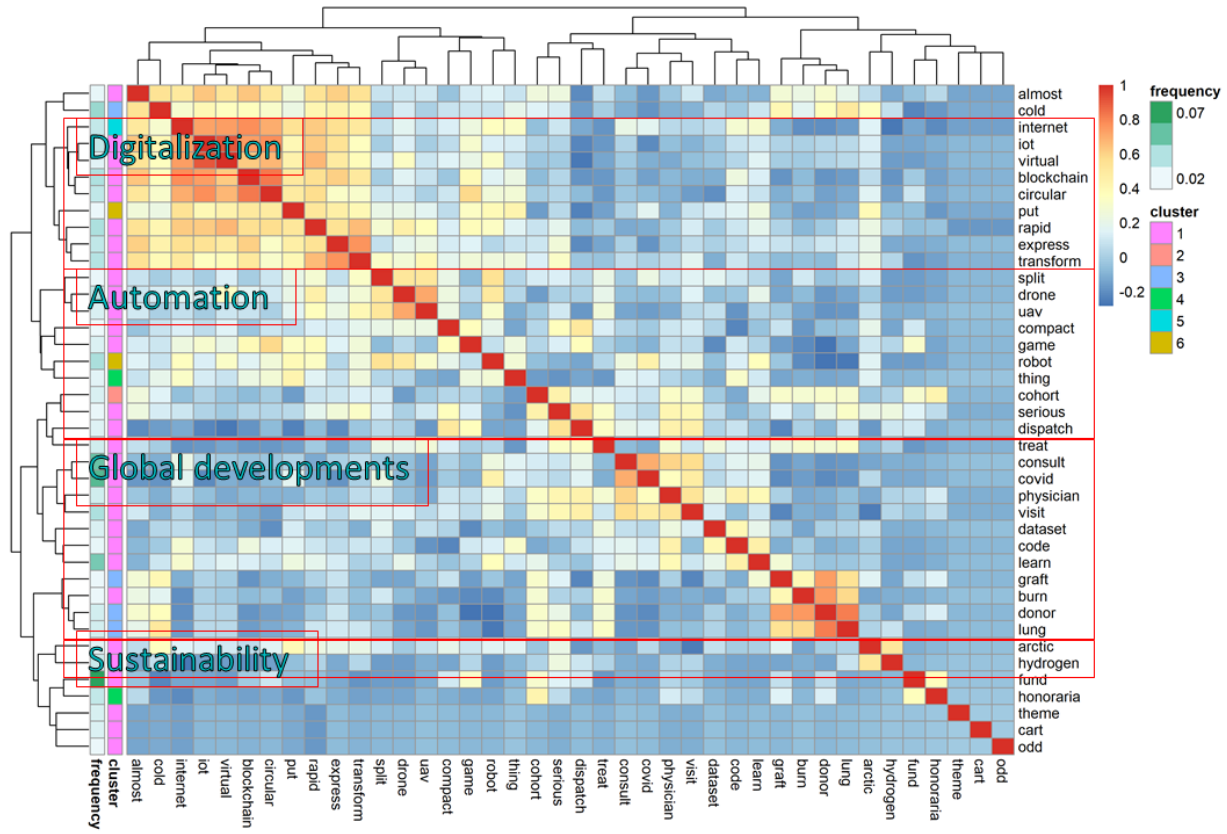
Figure 5. Heatmap of the correlation of 80 most abundant words in the 2019 – 2021 COVID-19 period.